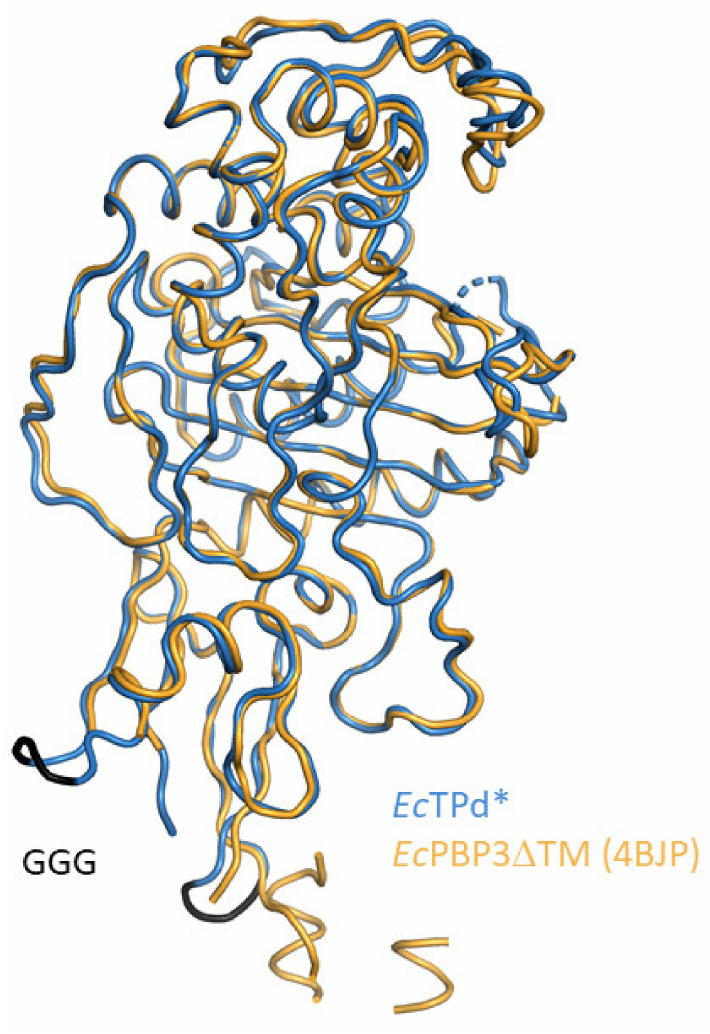
Figure A2. Superposition of the X-ray structures of the Ec TPd* protein introduced in this study (dark blue) and Ec PBP3 ∆ TM published previously (PDB entry 4BJP, gold), demonstrating the similar coverage of ordered structure. The GGG linkers replacing the deleted segments in Ec TPd* are colored